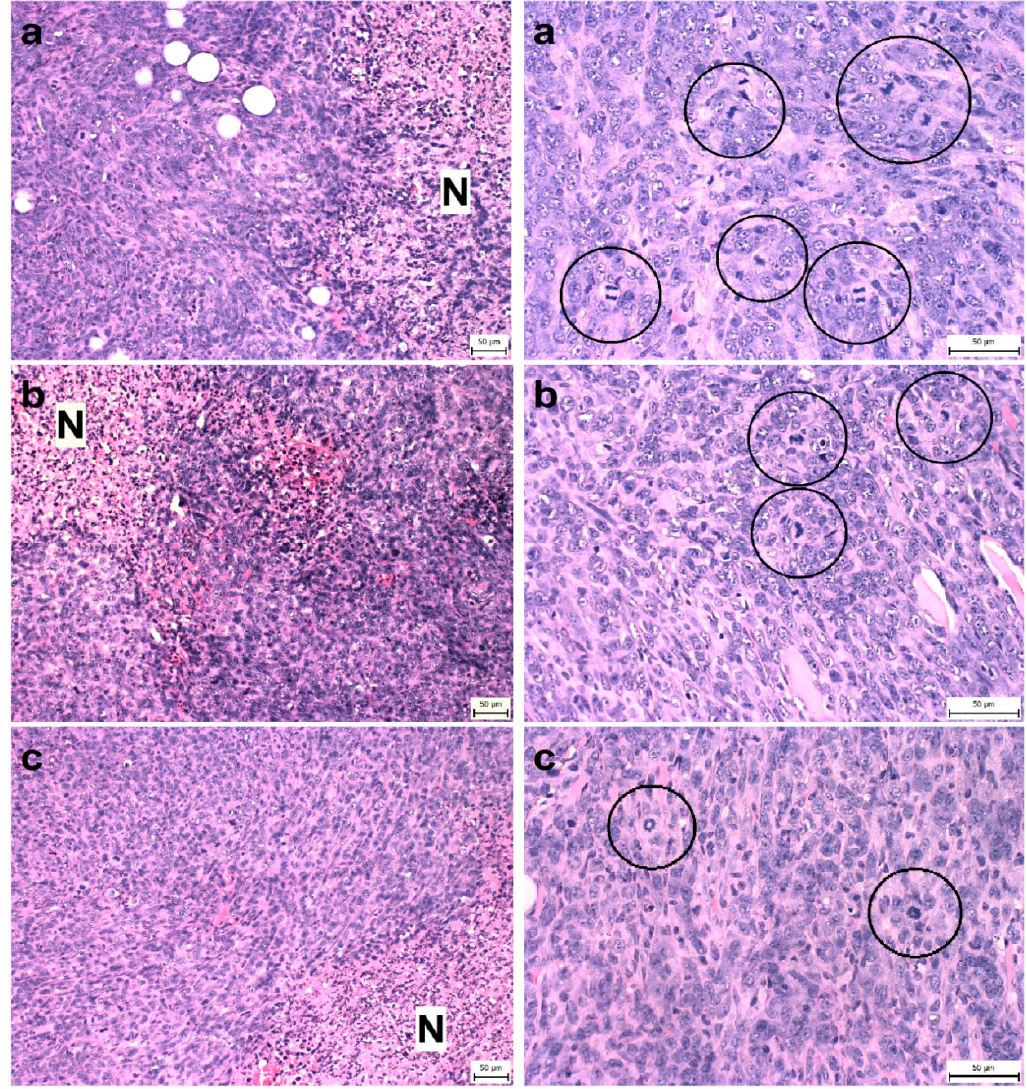
Figure 2. Proportion of necrosis in tumor tissue (N / TT) (left column) and mitotic activity index (MAI) (right column) after treatment with T. vulgaris in 4T1 tumors in Balb / c mice. Tumor necrosis (N)